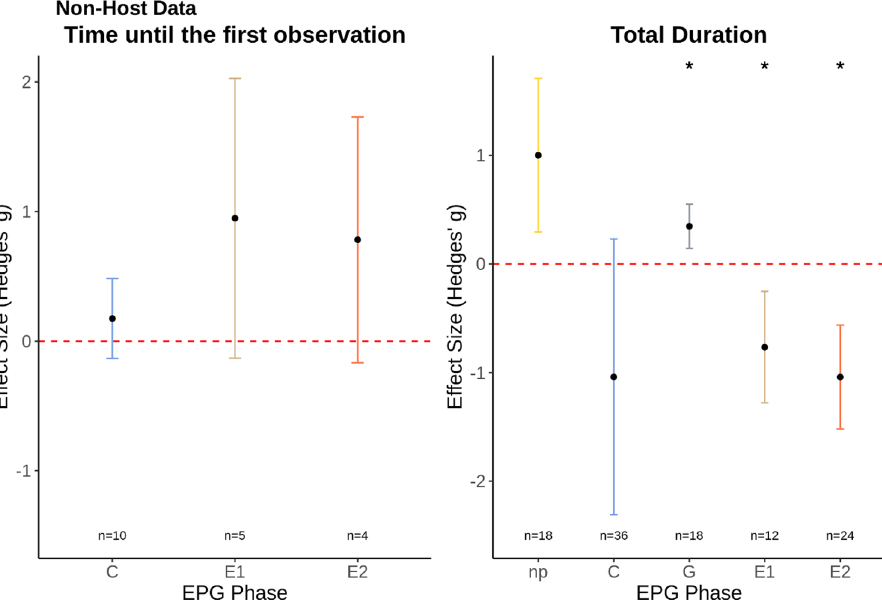
Figure 5. ( A ) The mean effect size for each EPG phase for the non-host “Time until first observation” sub- dataset; ( B ) the mean effect size for each EPG phase for the non-host “Duration” sub-dataset. *EPG phases significantly impacted by non-host plant resistance. Graphs displays the mean effect size (Hedges’ g) and the 95% confidence intervals. Red dashed line displays the zero effect